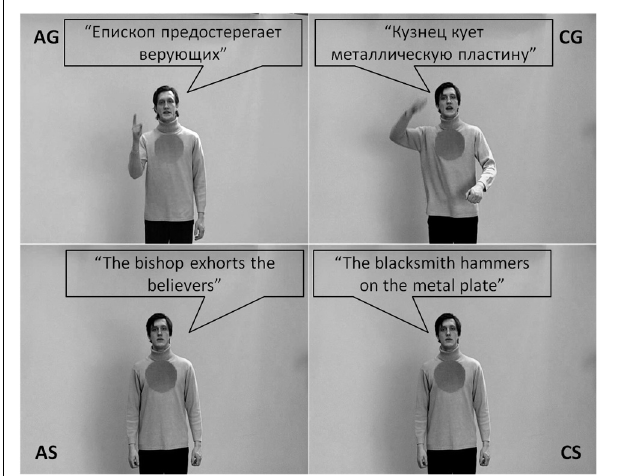
FIGURE 1 | For each of the four conditions (AG, abstract-gesture; CG, concrete-gesture; AS, abstract-speech; CS, concrete-speech) an example of the stimulus material is depicted. Note: For illustrative purposes the spoken German sentences were translated into English and all spoken sentences were written into speech